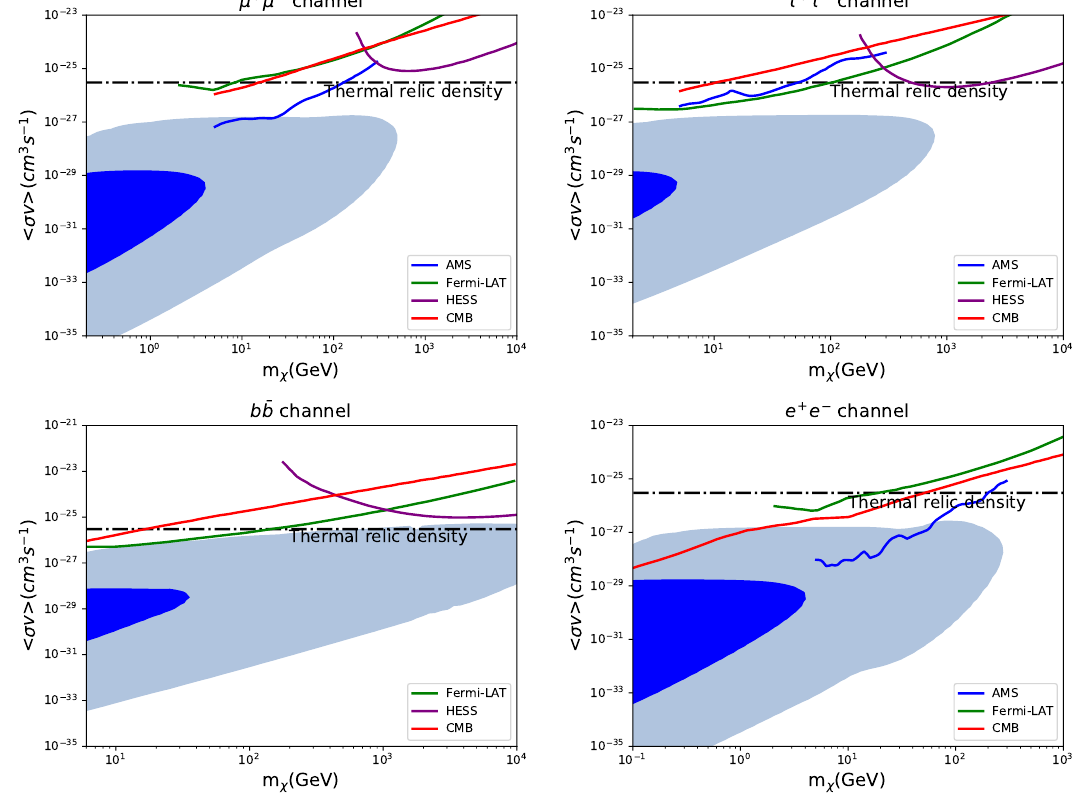
Figure 4 . Limits on Dark Matter Annihilation. Constraints on the WIMP pair annihilation cross section as a function of the WIMP mass at µ + µ − , τ + τ − , b ¯ b , e + e − channels by EHT M87 ? result, the dark and light blue contour limits assume magnetic field are 30 G and 1 G, respectively. Other constraints, as the legend applies to all panels, from the AMS (blue line; [27]), the Fermi-LAT (green line; [28]), H.E.S.S. (purple line; [31]), CMB (red line; [29]) and thermal relic abundance (black